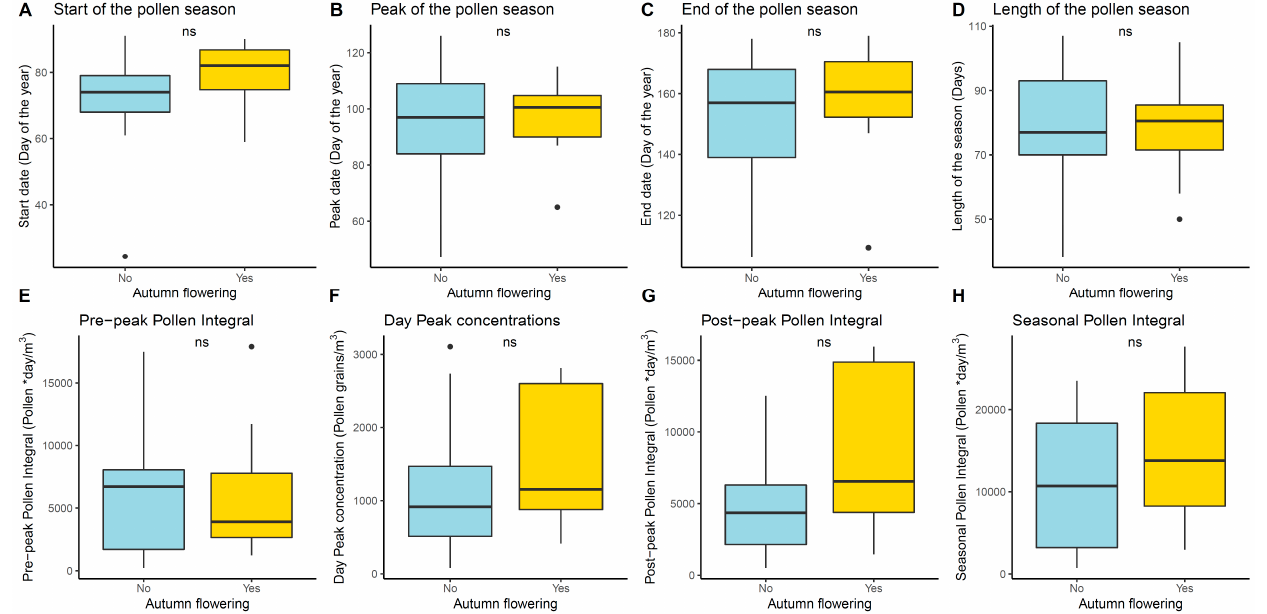
Figure 4. Box plot showing the distribution of pollen season features of the main pollen season registered in the springs of the years in which an autumn flowering was observed: 1999, 2002, 2006, 2009, 2012, 2014, and 2015. Autumn pollen integral > 100 pollen grains * day /m 3 , yellow) and years without autumn flowering (blue). Mann–Whitney–Wilcoxon test significance levels: non-significant ( ns ), significant at p -value: 0.05 *, 0.01 ** and 0.001 ***.